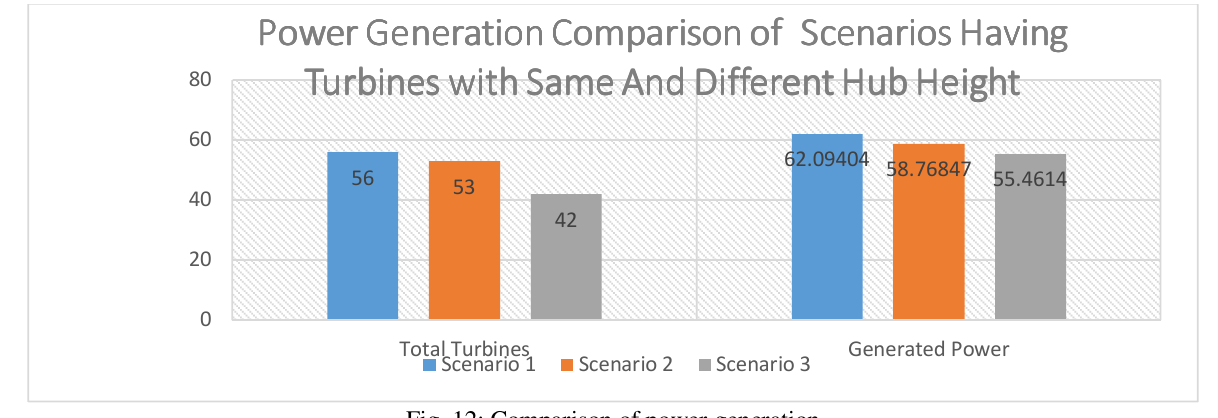
Fig. 12: Comparison of power